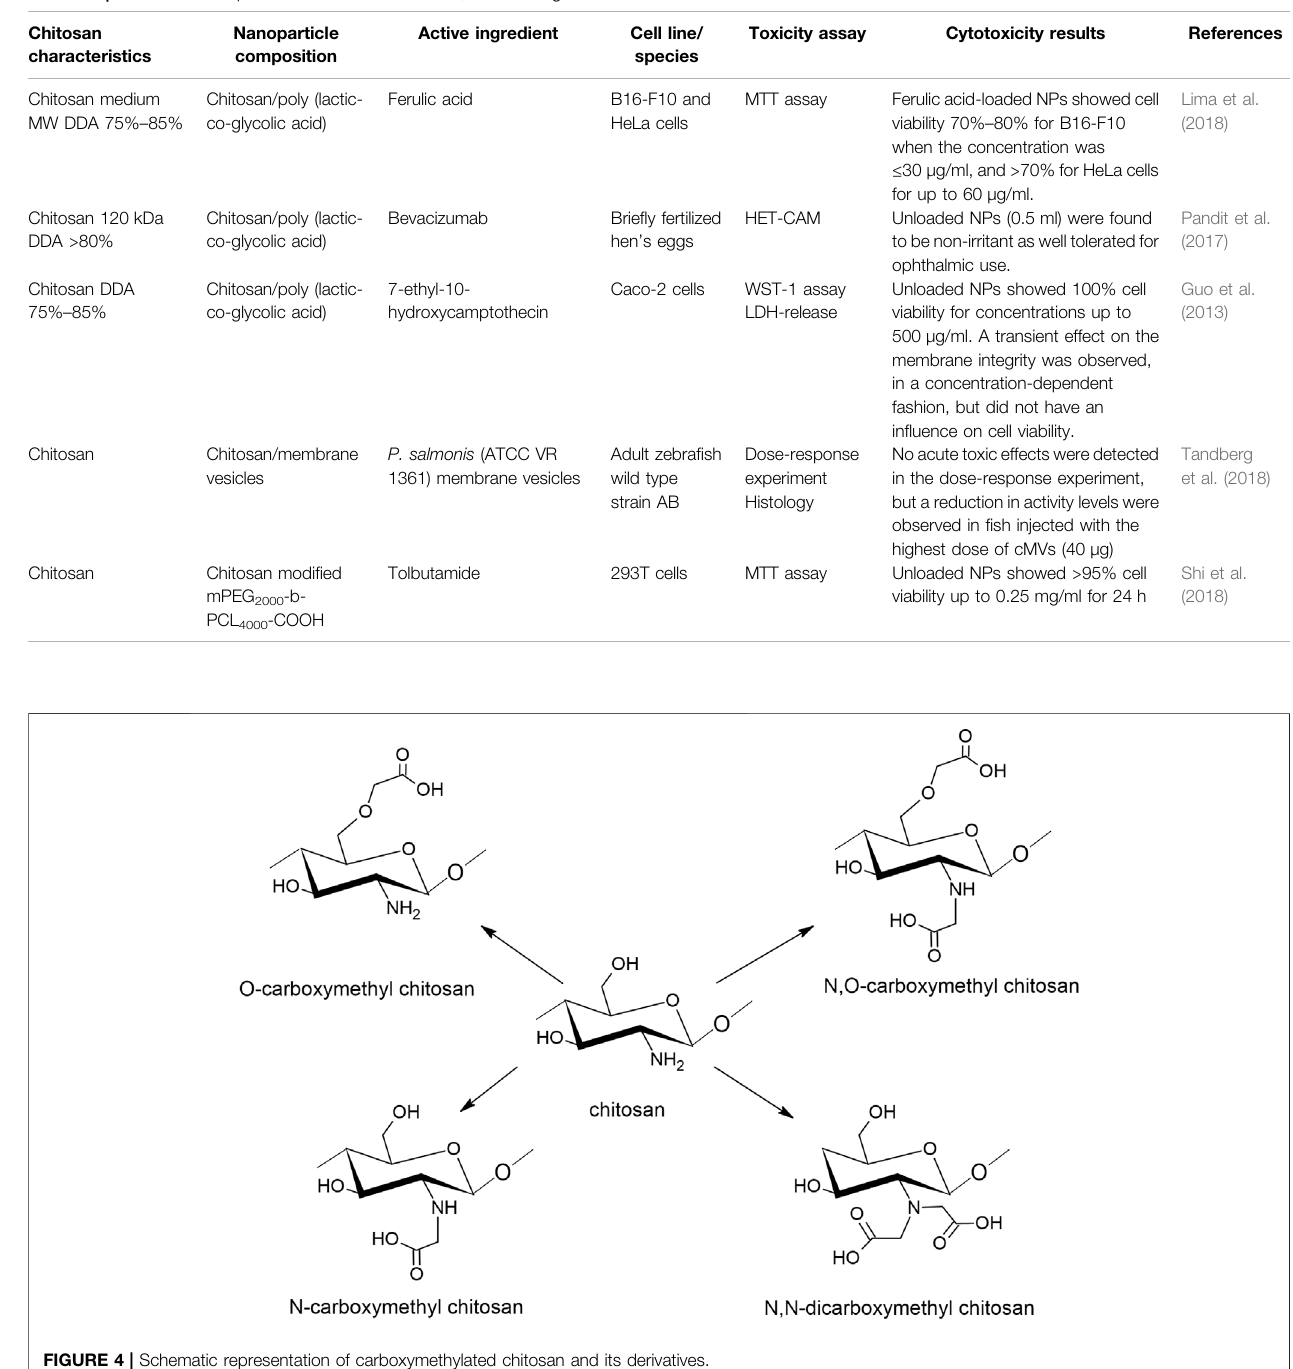
Frontiers in Pharmacology |